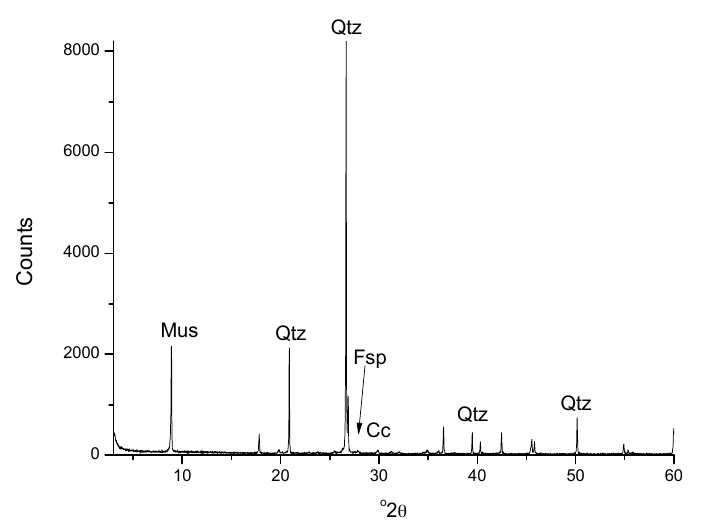
Figure 9. XRD pattern of sample area 3 (Mus: Musc ovite, Qtz: quartz, Fsp: feldspars, Cc: calcite).